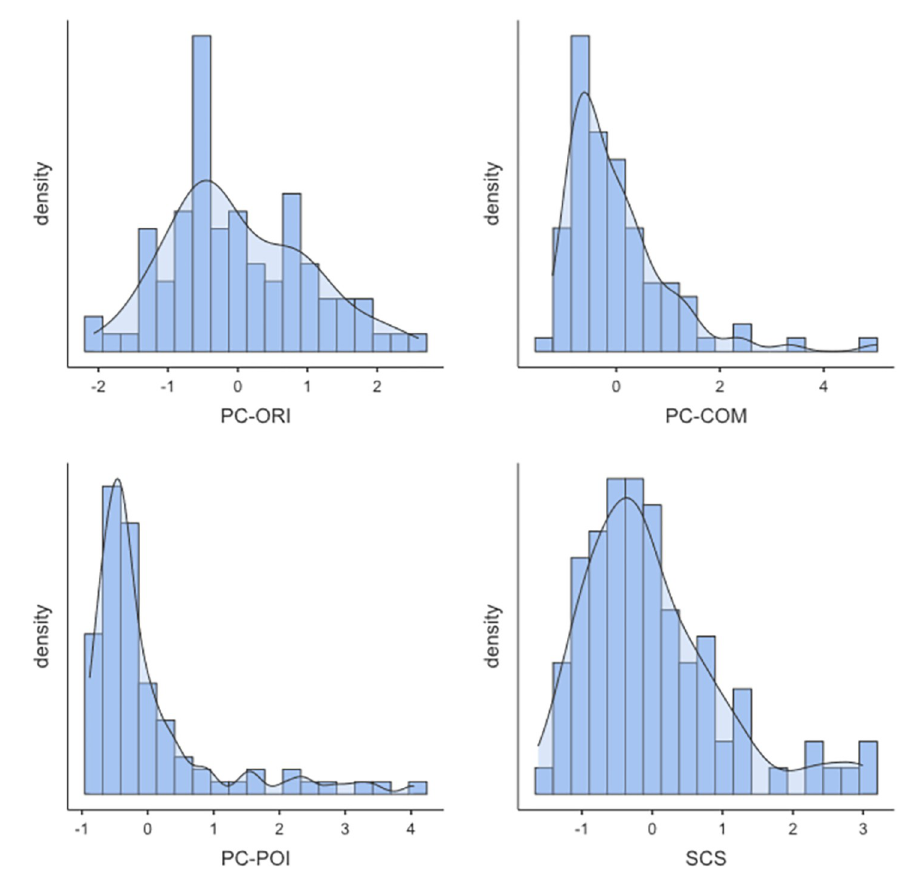
Fig 2. Distribution of infants’ socio-cognitive development continuous measures: Orienting to auditory source, PC-ORI; pointing to auditory source, PC-POI; communication to auditory source, PC-COM; cumulative socio- cognitive score,